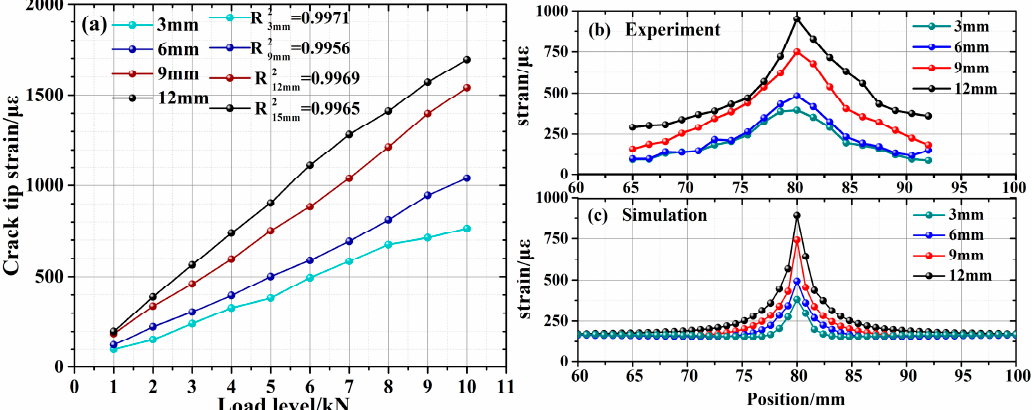
Figure 7. Strain measurement at different crack lengths and load levels: ( a ) experimentally measured crack tip strain; ( b ) experimentally measured non-uniform strain distribution; ( c ) simulated non-uniform strain distribution around the crack tip.